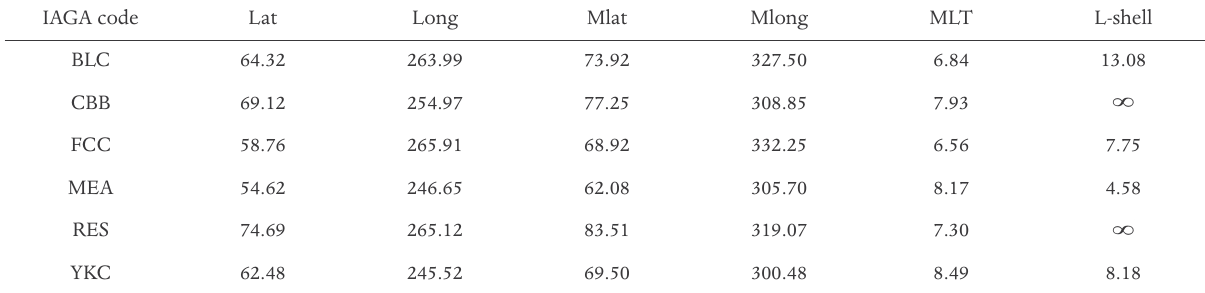
Table 1. List of geomagnetic observatories selected in this work. Observatories are identified using their IAGA code. Geographyical and cor- rected magnetic coordinates are given in degrees. MLT is given in UT (hours) at time when given point is at midnight. L-shell is given in Earth’s radii R . The geomagnetic coordinates were calculated for 1996.0 using the routine available at E